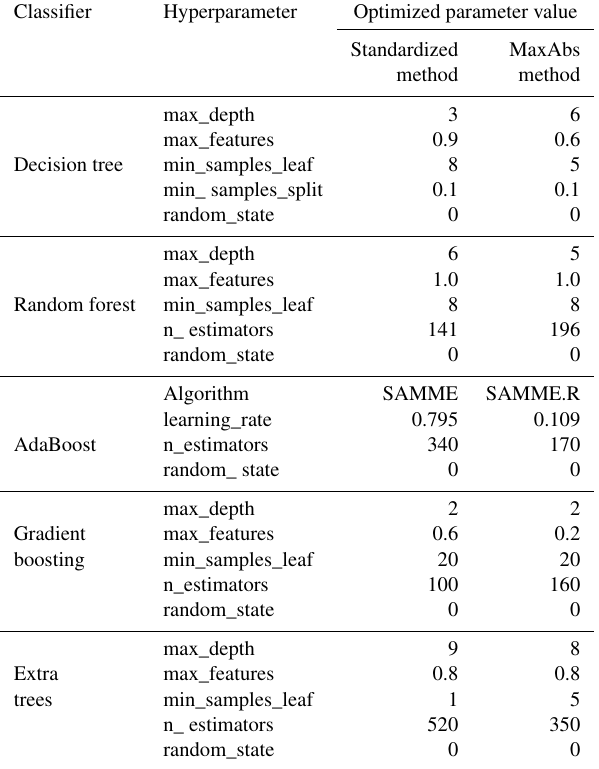
Table 3. Algorithm hyperparameters (description after Pedregosa et al., 2011) and adjusted outcomes. The hyperparameters uti- lized are as follows: max_depth – the maximum depth of the tree; max_features – the number of features to consider when looking for the best split; min_samples_leaf – the minimum number of samples required to be at a leaf node; min_samples_split – the minimum number of samples required to split an internal node; random_state – controls both the randomness of the bootstrapping of the samples used when building trees and the sampling of the features to be con- sidered when looking for the best split at each node; n_estimators – the number of trees in the ensemble methods; Algorithm – method used by AdaBoost (discrete SAMME boosting algorithm or real SAMME.R boosting algorithm); learning_rate – shrinks the con- tribution of each